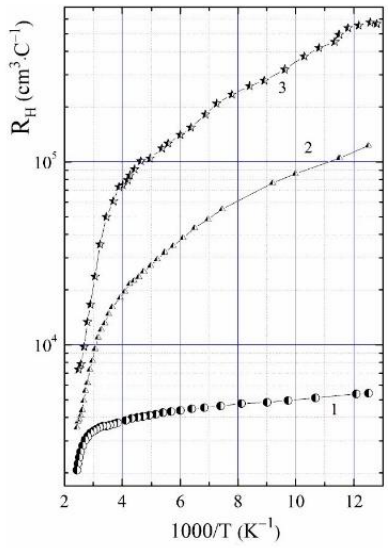
Figure 4. The in-plane electrical conductivity versus temperature for as-grown pristine (1), Co-in- tercalated (2) and Co-doped (3) n -type InSe crystals. Figure 5. The Hall coefficient versus temperature for as-grown pristine (1), Co-intercalated (2) and Co-doped (3) n -type InSe crystals.